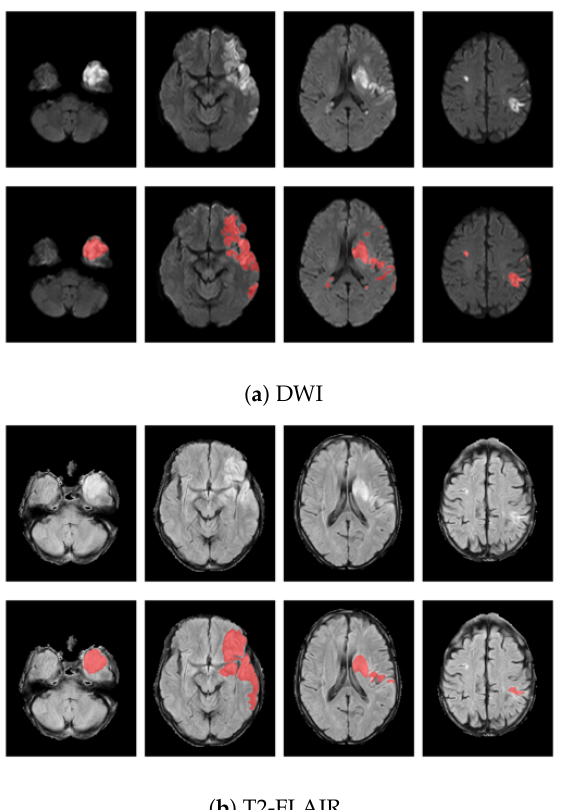
Figure 4. Example of infarct lesion segmentation on a selected slices sampled from ( a ) DWI and ( b ) T2-FLAIR preprocessed volumes. For each modality, original slices are displayed in the first row and lesion segmentation (red) is shown as overlapping the correspondent slices in the second